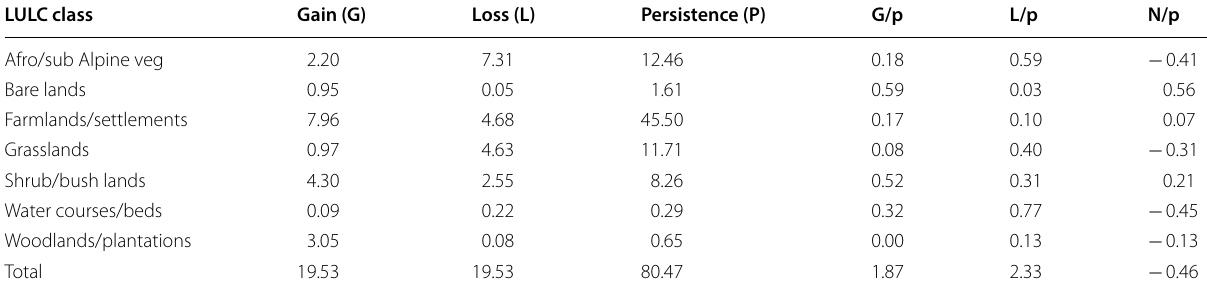
Table 8 Gain to persistent (g watershed